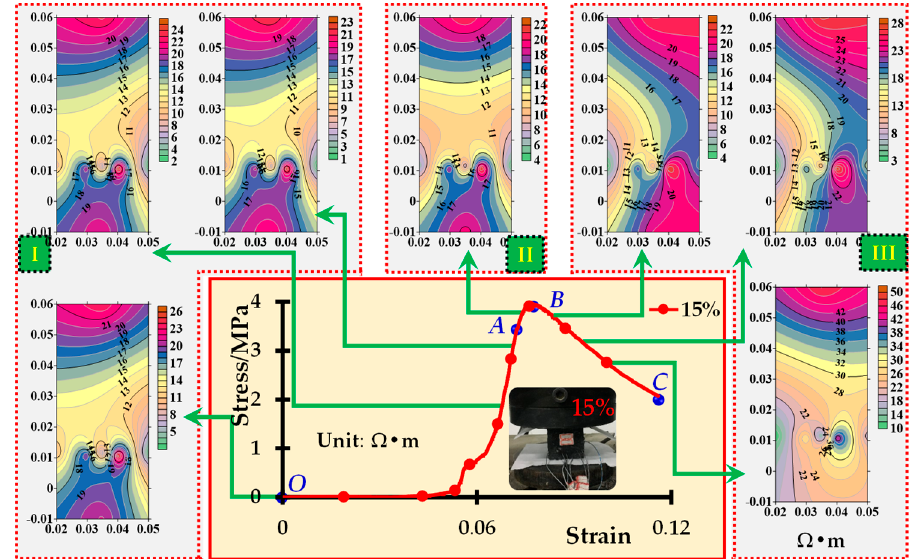
Figure 14. Variation charts of the specimen with 15% graphite at different stages.